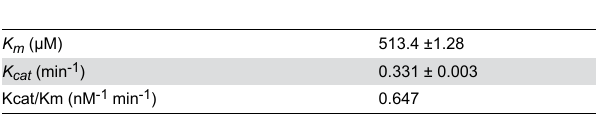
Table 1. Kinetic data for Sp MetAP1a.